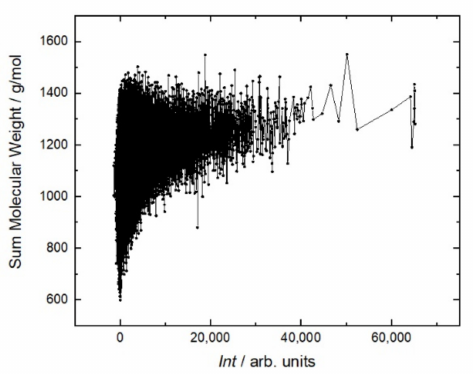
Figure 5. Fluorescent intensity Int of RTX interaction with the resemblance-ranking peptide library versus the sum molecular weight of the corresponding peptides.